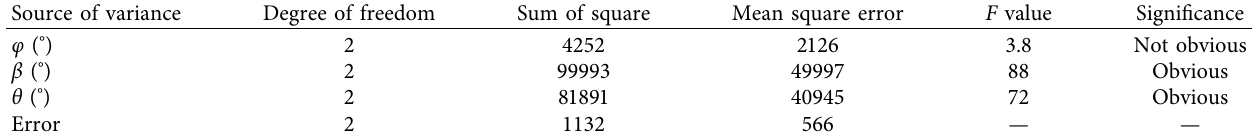
Table 4: Variance analysis table of average radial electromagnetic force.